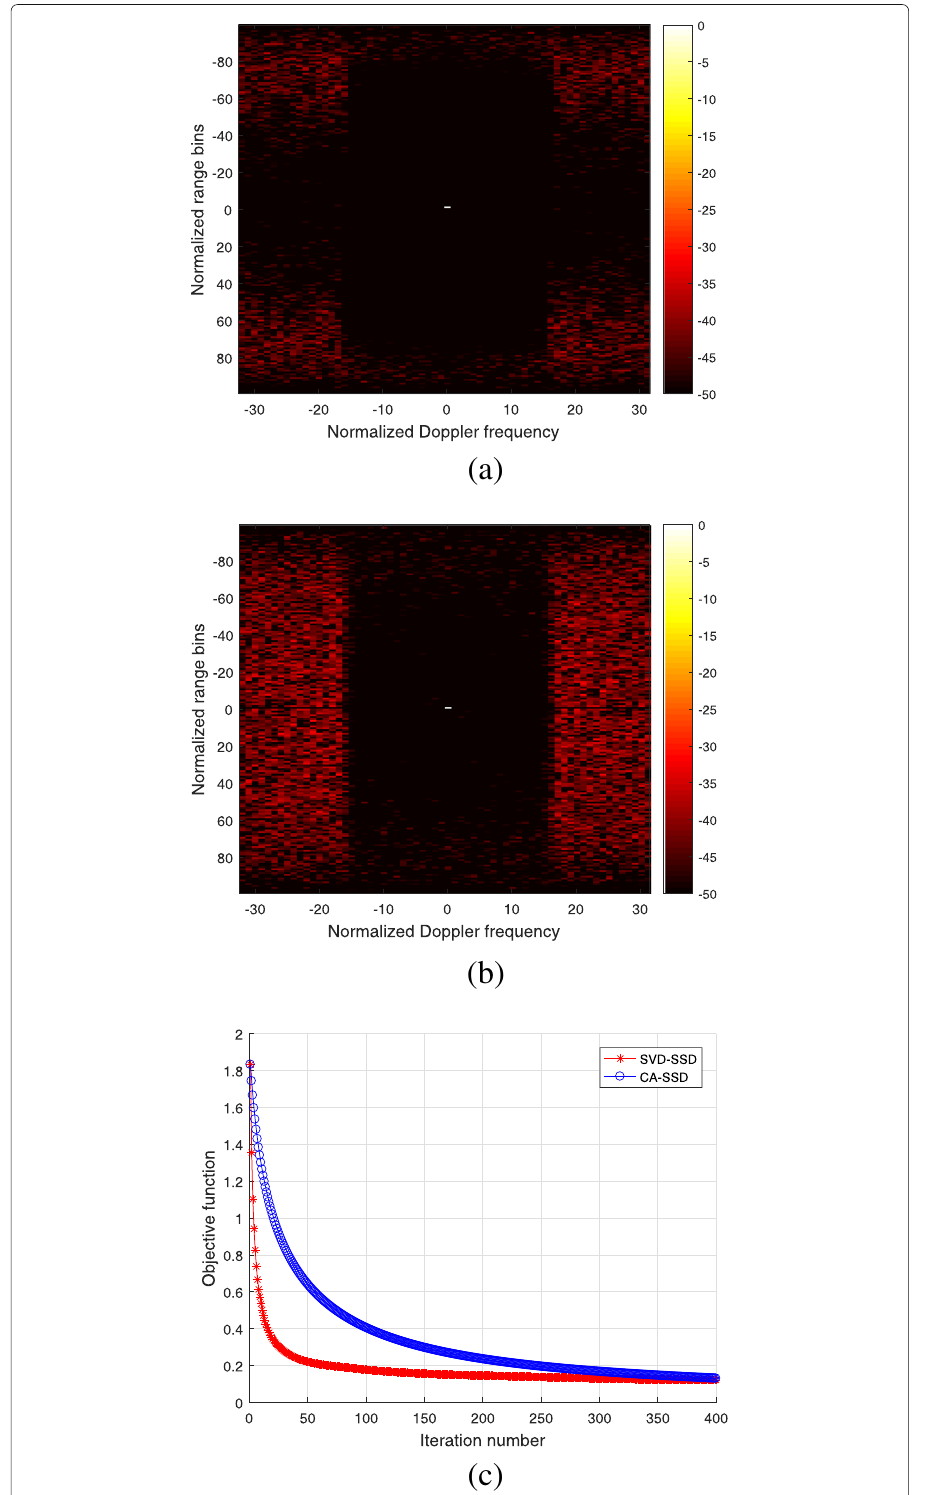
Fig. 1 The shape of SRDAF of sequence set optimized by SVD-USSD and CA-USSD algorithms, a SVD-USSD algorithm, b CA-USSD algorithm, c the curve of the objective function vs. iteration number of SVD-USSD and CA-USSD